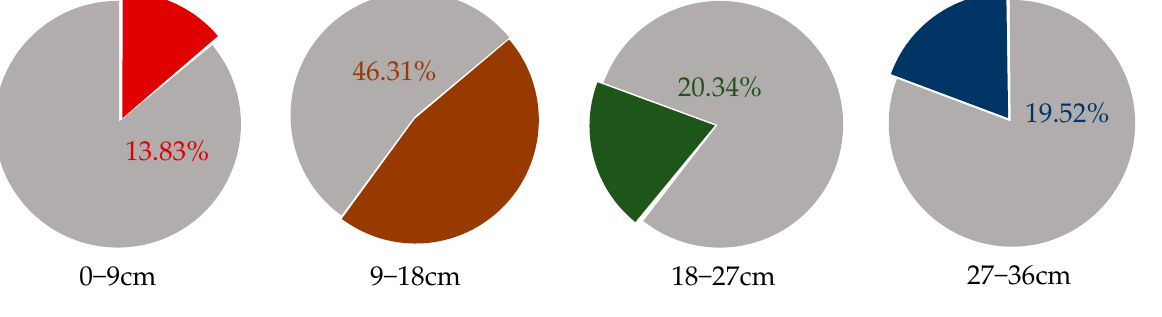
Figure 2. Measured